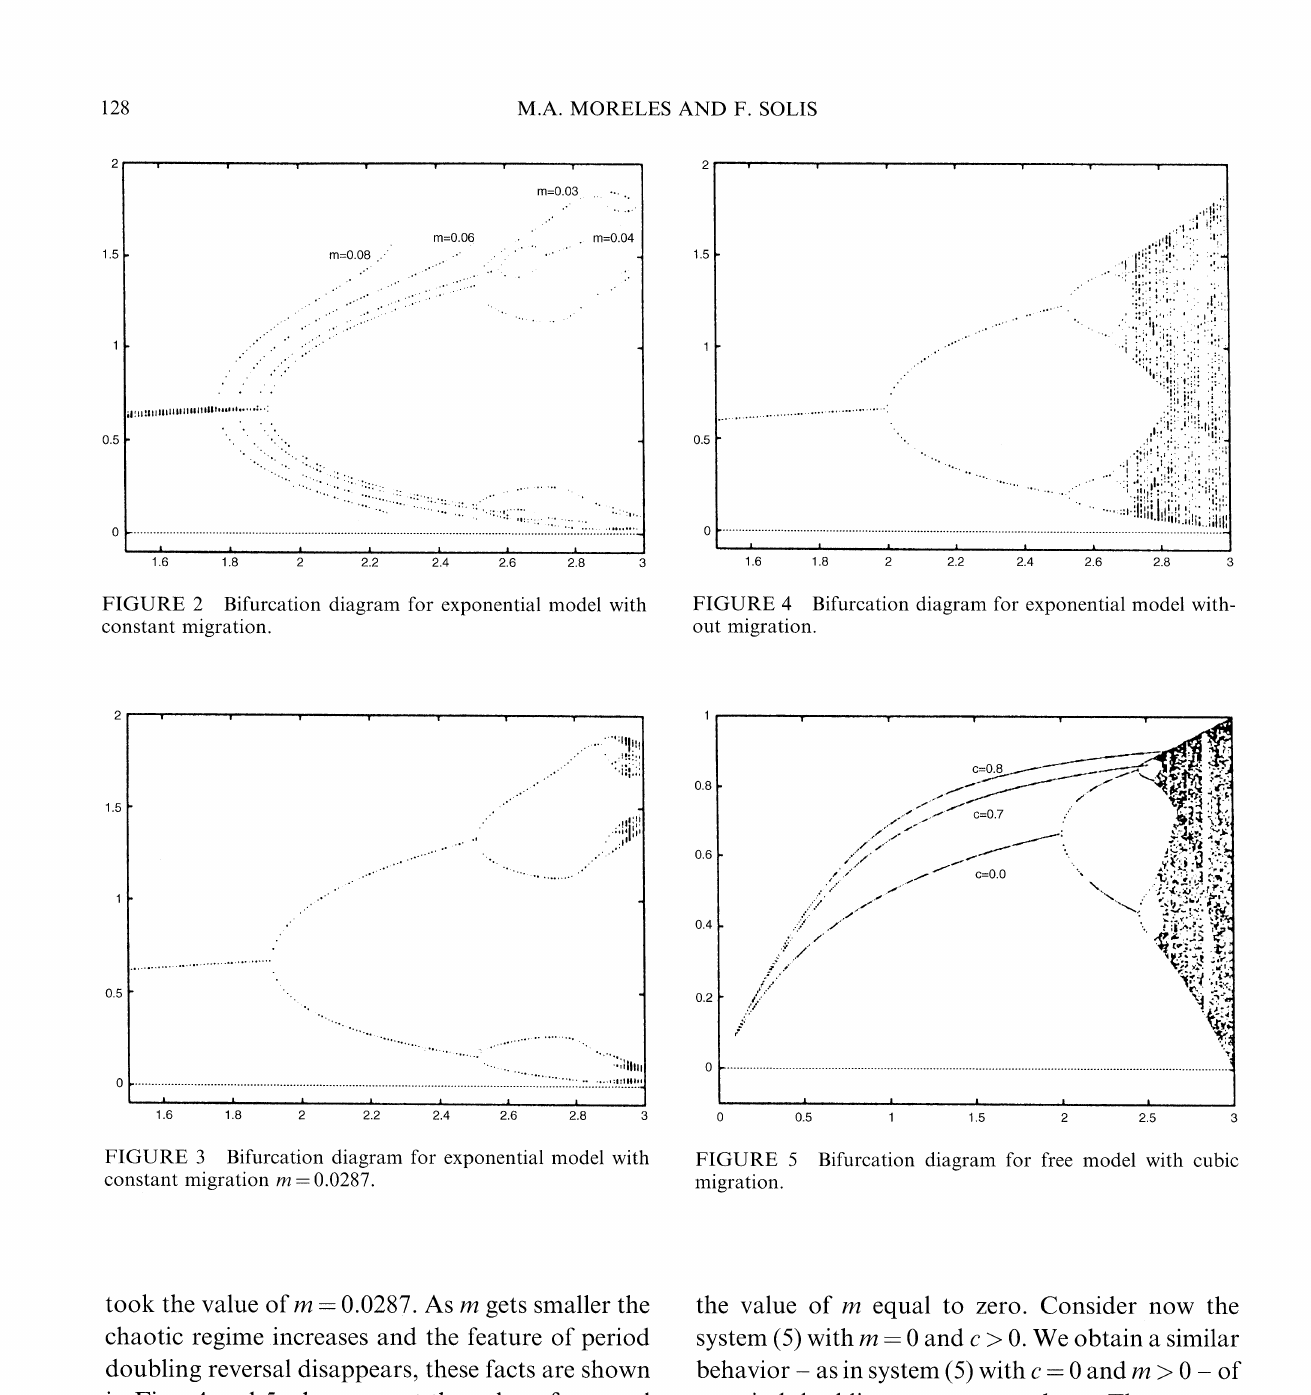
FIGURE 4 Bifurcation diagram for exponential model with- out migration.